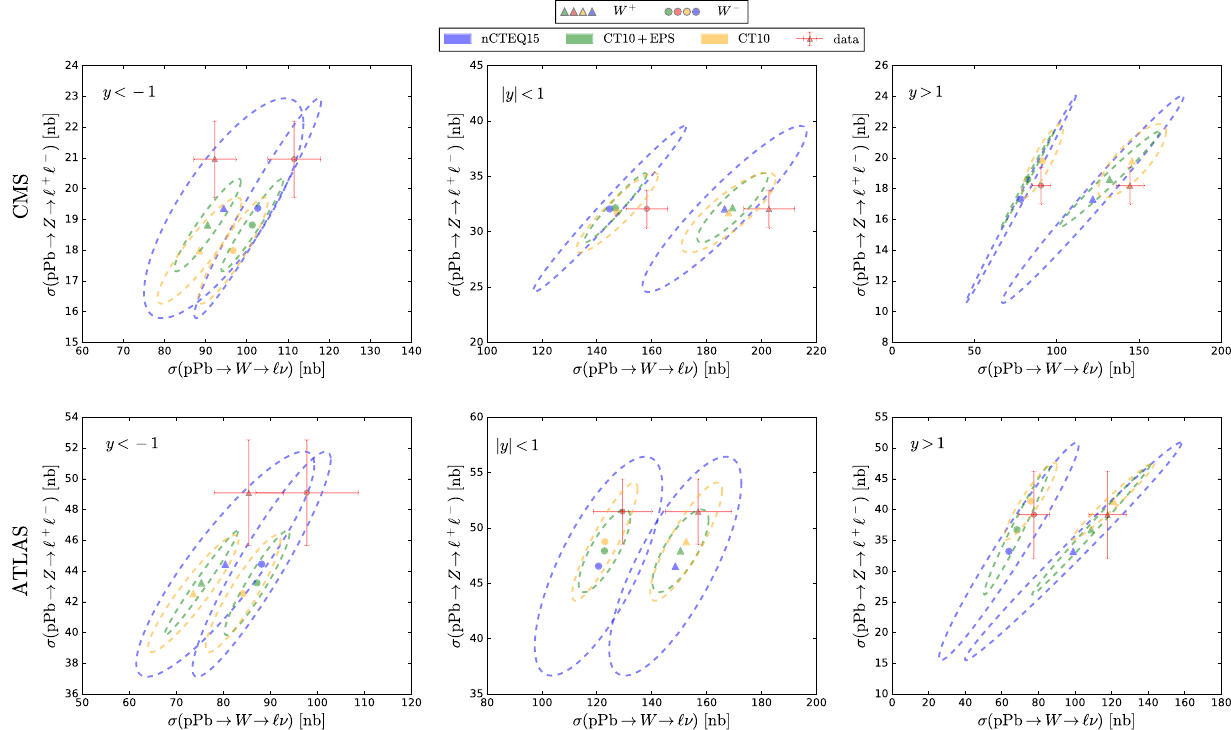
Fig. 11 Correlations between W + and W − cross sections calculated with different PDFs overlaid with the corresponding LHC data from CMS and ATLAS